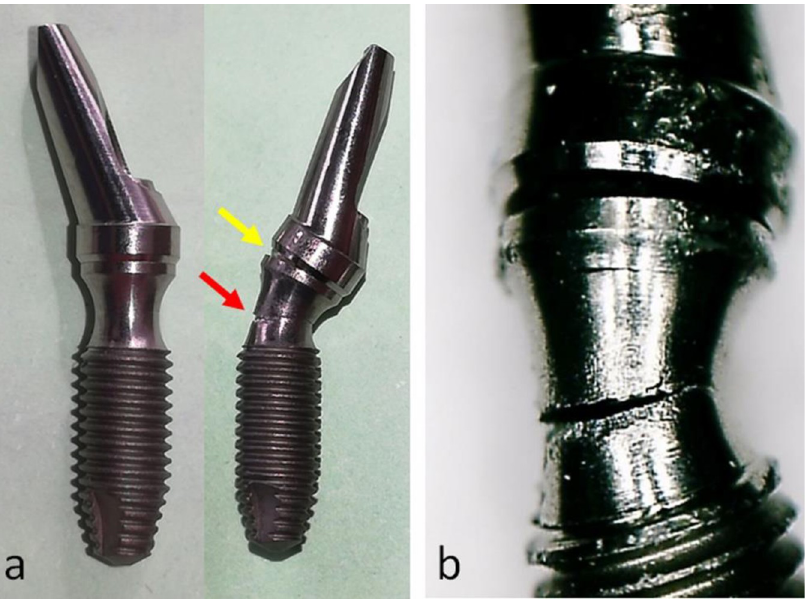
Fig 8. (a) Representative images of a sample before (left) and after (right) the load application of the Collo out group. The yellow arrow indicates where there was a separation between the abutment and implant, and the red arrow shows where the implant fracture occurred in its thinnest portion (center of the neck). (b) Image with higher magnification showing the details of the sample changes after the test.